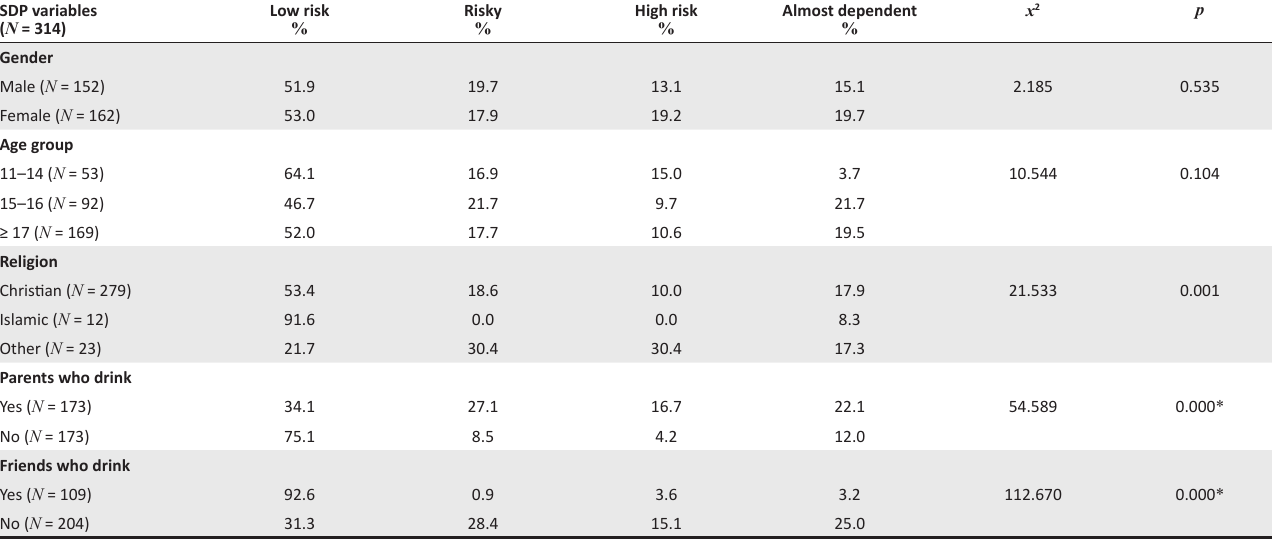
TABLE 2: Alcohol Use Disorders Identification Test classification according to Sociodemographic profile.